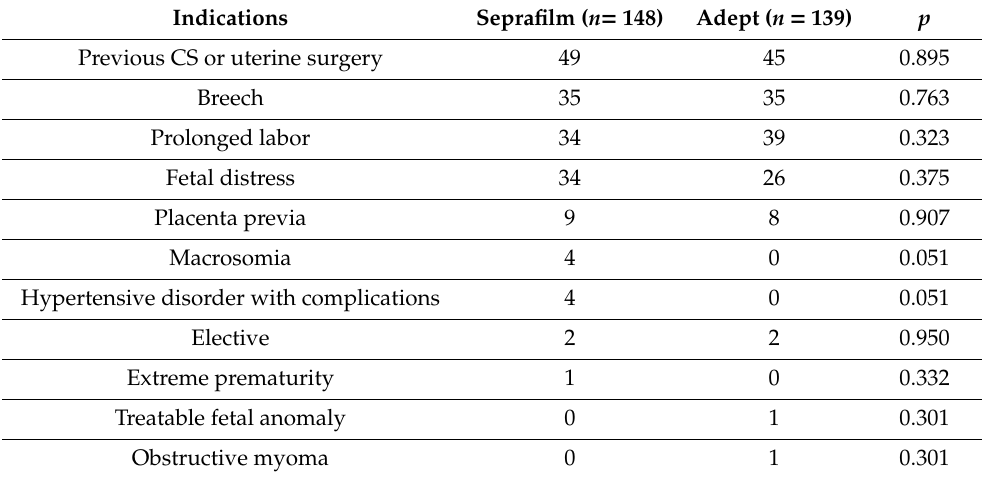
Table 2. Indications of emergency cesarean.